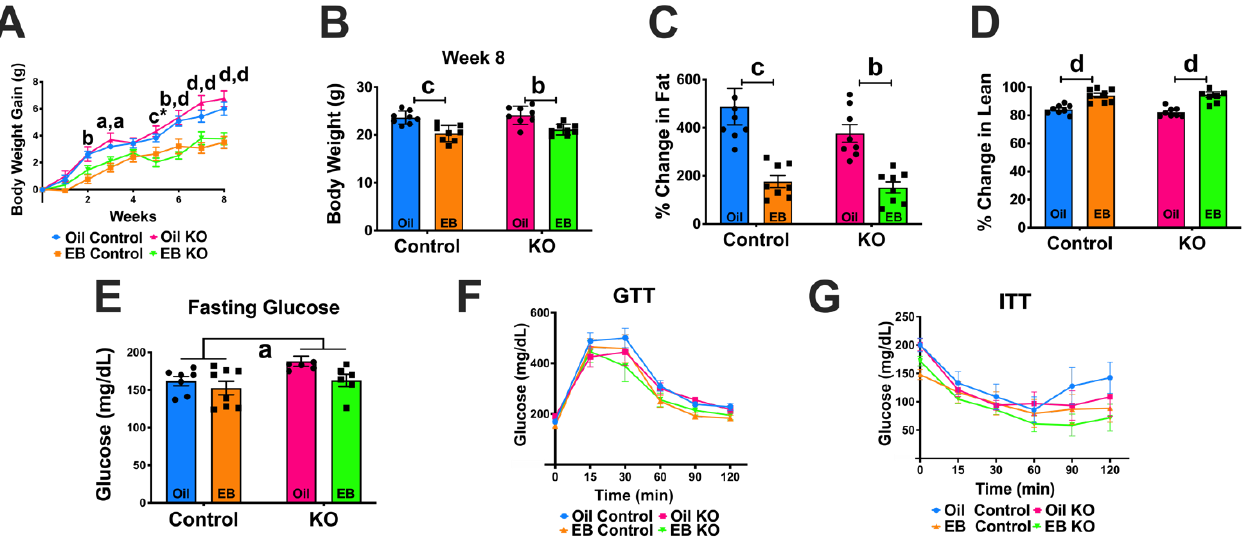
Figure 2. Response to ovariectomy for OVX Oil- and EB-exposed control and Kiss1-GHSR KO (KO) female mice fed LFD for 8 weeks. ( A ) Weekly body weight gain (grams), ( B ) Week 8 body weight ( C ) Percent change in fat mass, ( D ) Percent change in lean body mass ( E ) Fasting (5 h) glucose ( F ) Glucose tolerance test (GTT) and ( G ) Insulin tolerance test (ITT). For ( A ): Single lowercase letters denote a steroid effect within controls only, single lowercase letters with * denote a steroid effect within Kiss1-GHSR-KOs only, two lowercase letters denote a steroid effect in control and Kiss1-GHSR-KOs, respectively, and uppercase letters denote significance between genotypes within the same treatment. For ( B – D ): Capped lines with lowercase letter denote a steroid effect. For ( E ): lowercase letter under the line denotes main effect of genotype. A/a = p < 0.05; B/b = p < 0.01; C/c = p < 0.001; D/d = p < 0.0001. Data are represented as mean ± SEM, n = 8 mice per group. Data were analyzed with two-way ANOVA with post hoc Holm–Sidak’s multiple comparison test. Mice were OVX at 8 weeks of age and were 25–30 weeks of age at time of sacrifice. All females consumed more oxygen (V.O2) during the night compared to the